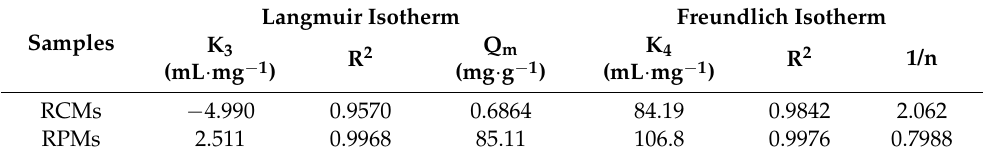
Table 2. Parameters of Langmuir adsorption model and Freundlich adsorption model.